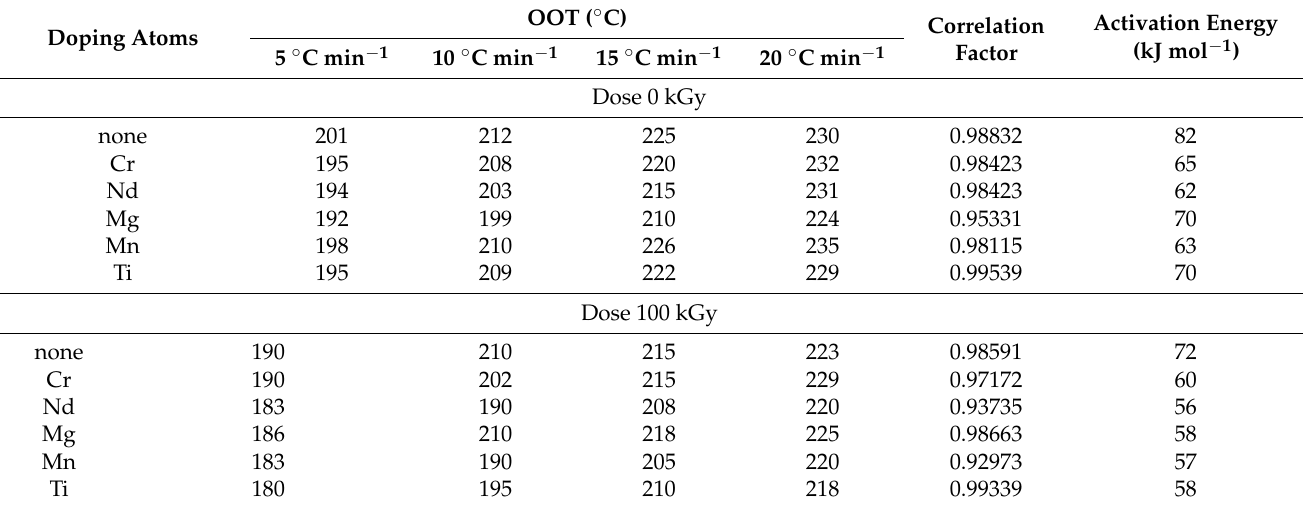
Table 2. Activation energy values of the degradation of PCL PbZrO 3 samples loaded with various metallic atoms.